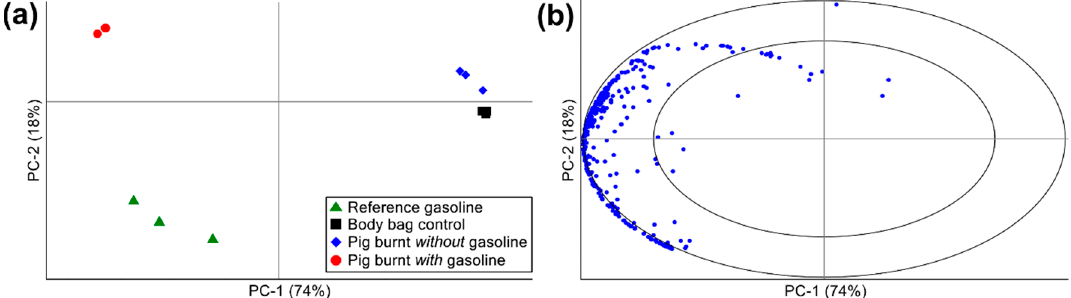
Figure 5. PCA ( a ) scores and ( b ) correlation loadings plots calculated using pre-processed GC×GC-TOFMS peak area data for all analytes of interest detected across the four sample classes: (1) reference gasoline ( n = 3); (2) body bag control ( n = 6); (3) pig burnt without gasoline ( n = 3); and (4) pig burnt with gasoline ( n = 3).